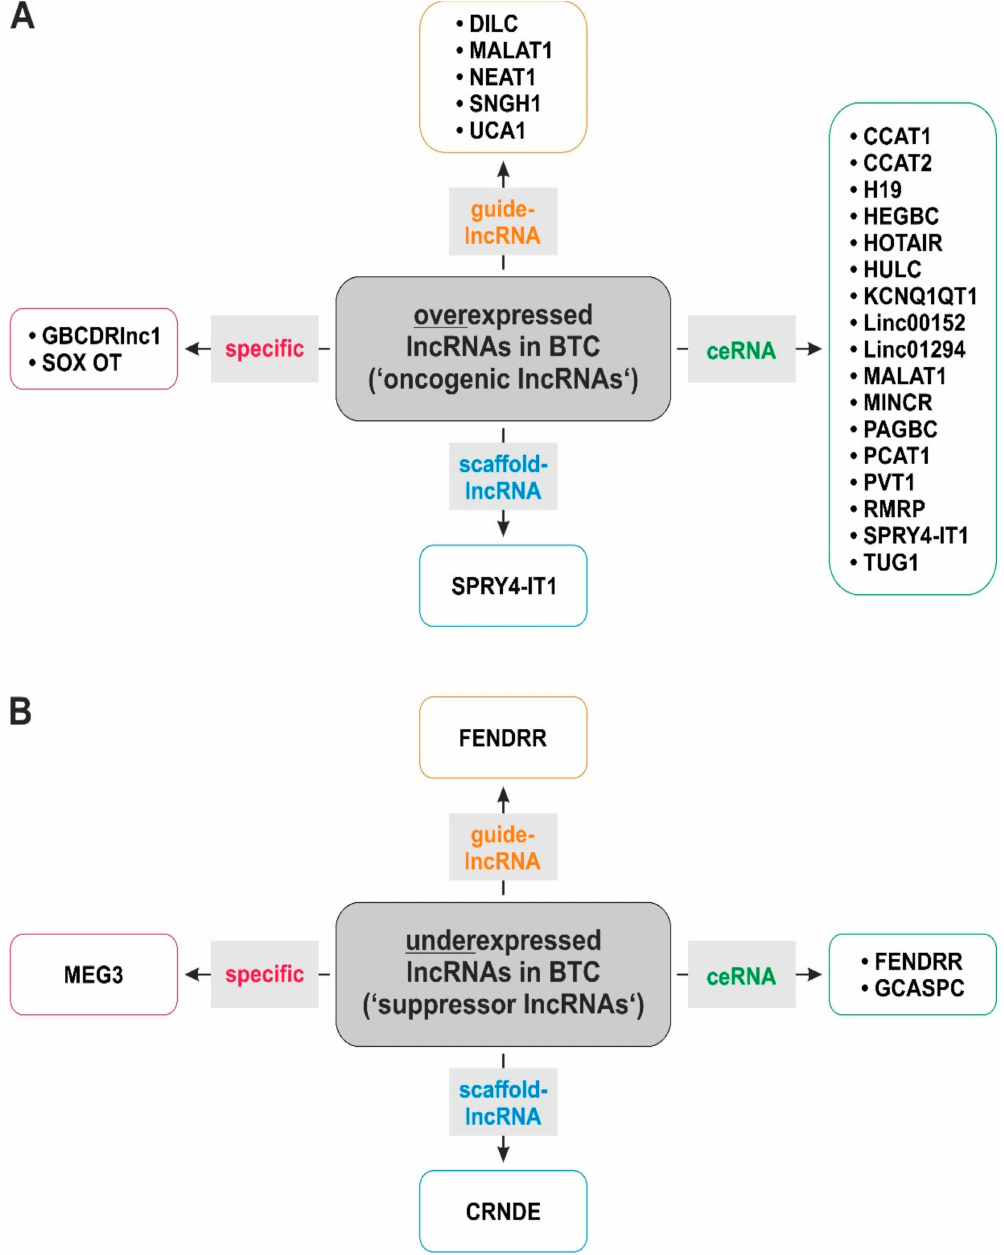
Figure 1. LncRNAs show functional diversity in biliary tract cancer as both oncogenic ( A ) and tumor-suppressive ( B ) lncRNAs. Abbreviations: lncRNA: long-noncoding